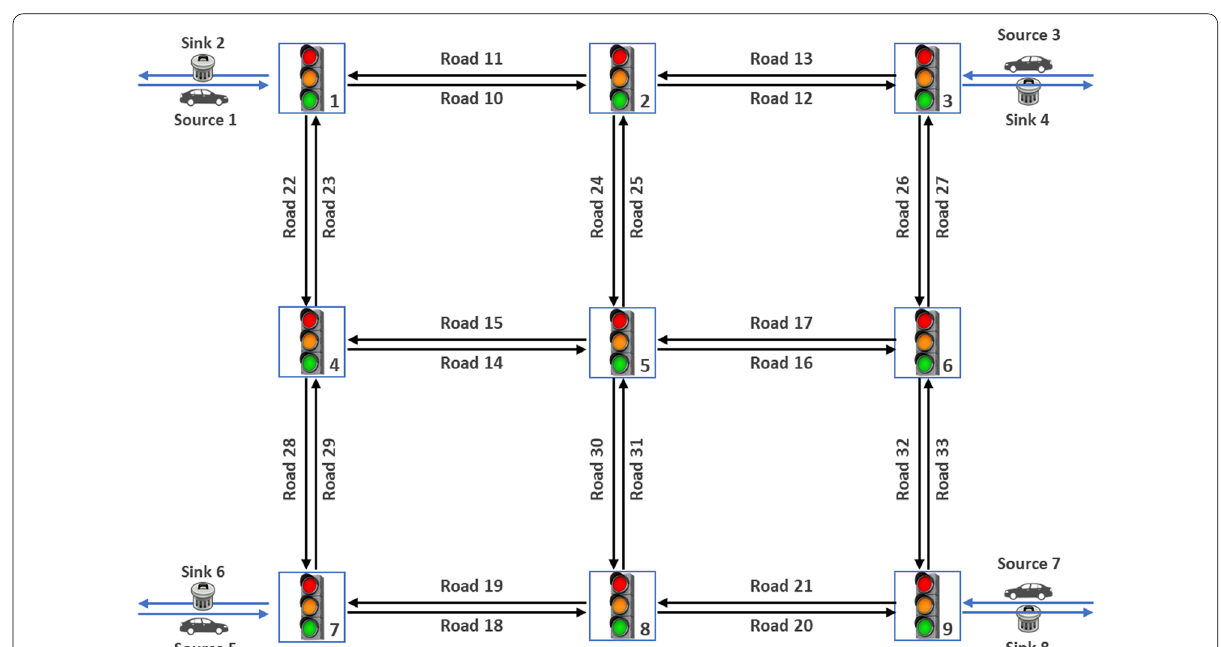
Fig. 9 representation of the nine-node grid network layout modelled with the CA & CTM